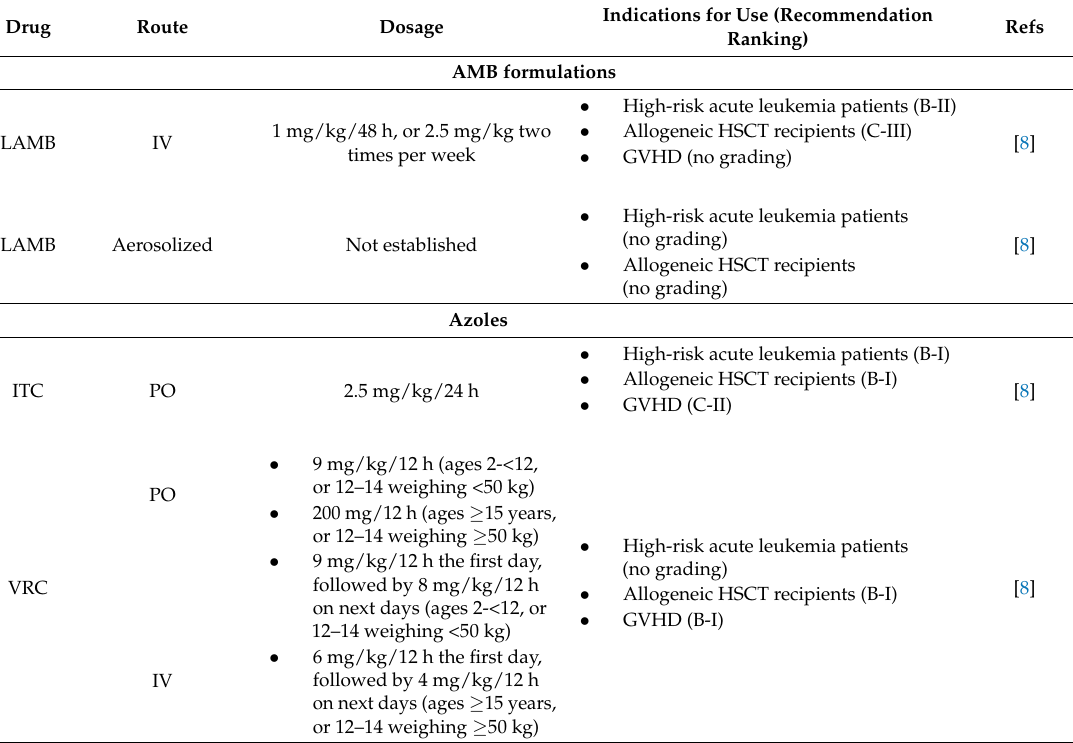
Table 3. Primary prophylaxis against Invasive